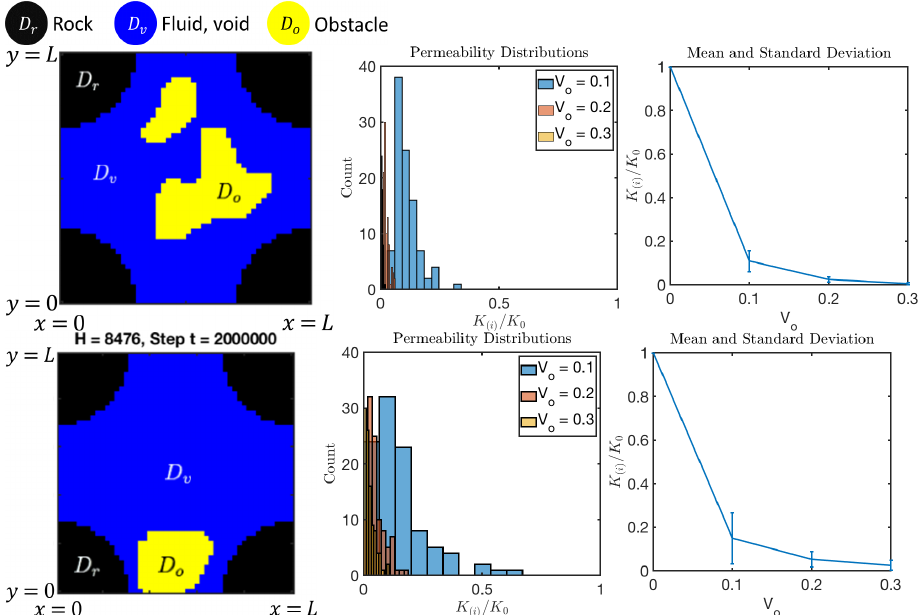
Figure 22. Results of CLPS (top) and LP (bottom) models for pore-filling in Section 6.1.2. Left: one of the realizations of domain D o . Middle: histogram of ( K ( i ) ) i for 3 values of V o . Right: mean and standard deviation of ( K ( i ) ) i for three values of V o .